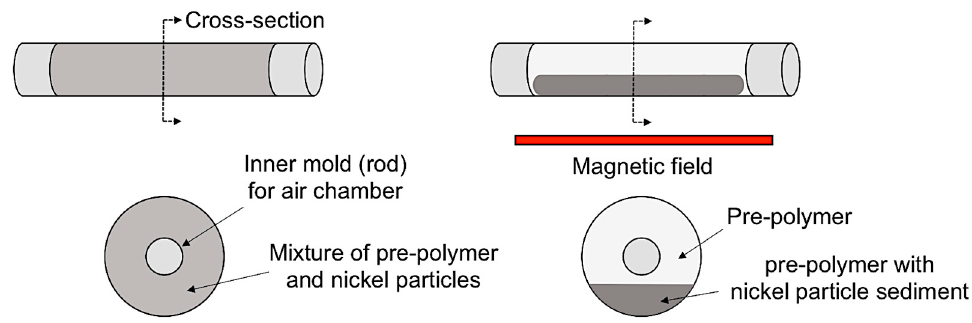
Figure 1. Schematic for fabrication of bilayer composite by using non-uniform magnetic field.